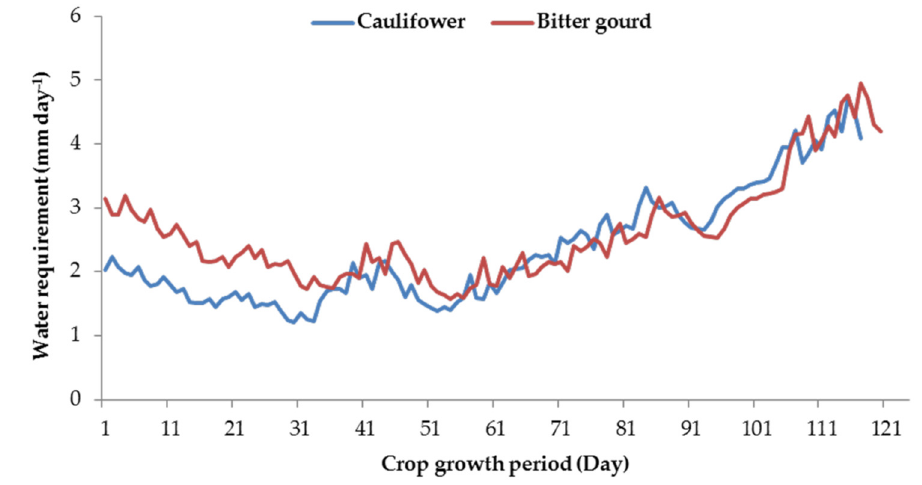
Figure 2. Crop water requirements (mm per day) of the cauliflower crop and bitter gourd crop.